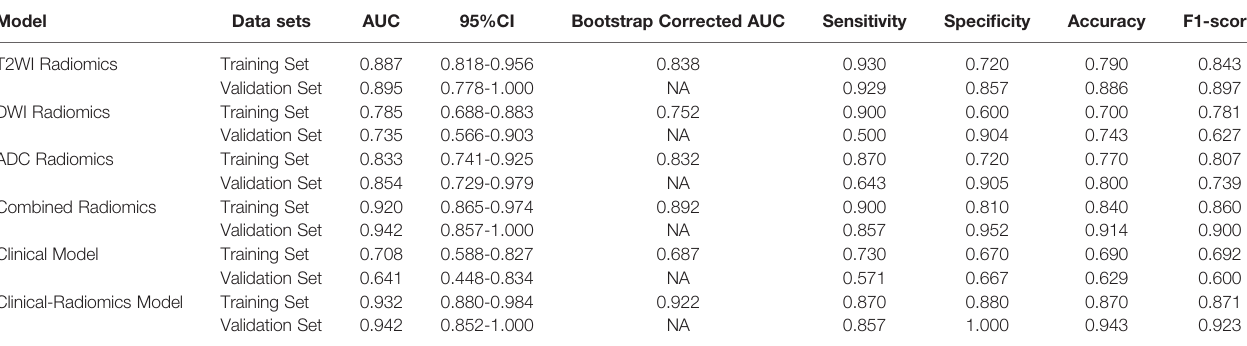
TABLE 4 | Performances of Different Models in the Training and Validation Sets.